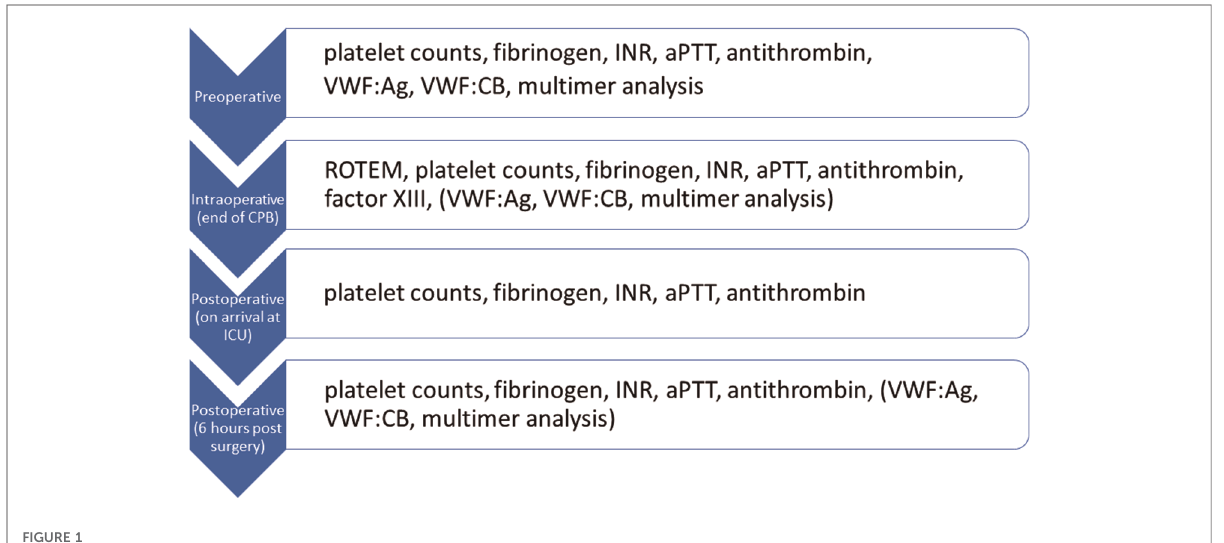
FIGURE 1 Work fl ow of departmental coagulation